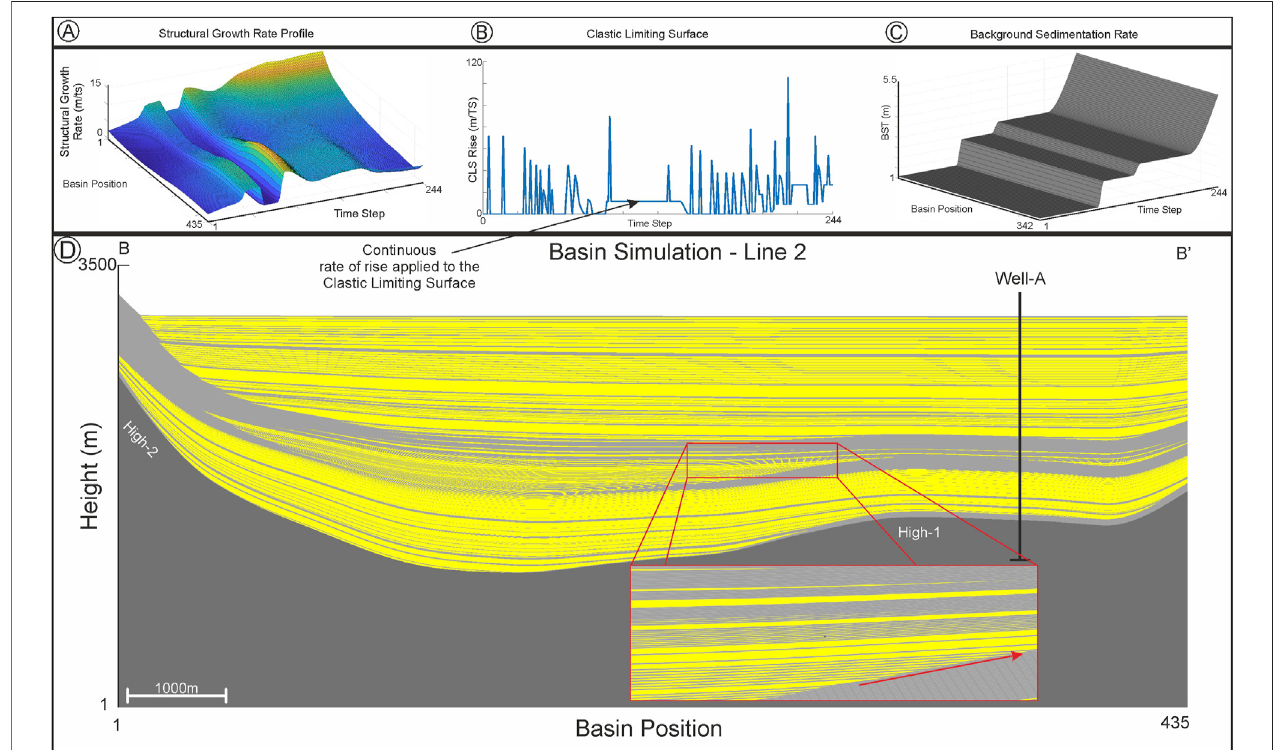
FIGURE8| InputsusedtomodeltheevolutionofLine2. (A) 3DrepresentationoftheStructuralGrowthPro fi le,amuch morecomplicatedstructuralgrowthhistory isvisiblecomparedtoLine1.Acombinationof2StructuralGrowthPro fi les,onerepresentstheeffectsofsalttectonicsandtheotherrepresentingthegrowthoftheFold. (B) The rateofriseoftheClastic LimitingSurfaceshows amoresustainedinputofgravity drivencurrentstoachieveagood match compared tothe more sporadic input in Line1. (C) Background Sedimentation Rate used inLine1isusedin Line2. (D) FinalsimulationforLine2.Insertsection highlightsthin gravity fl owdeposits, with red arrow showing the direction of onlap onto the basin fl